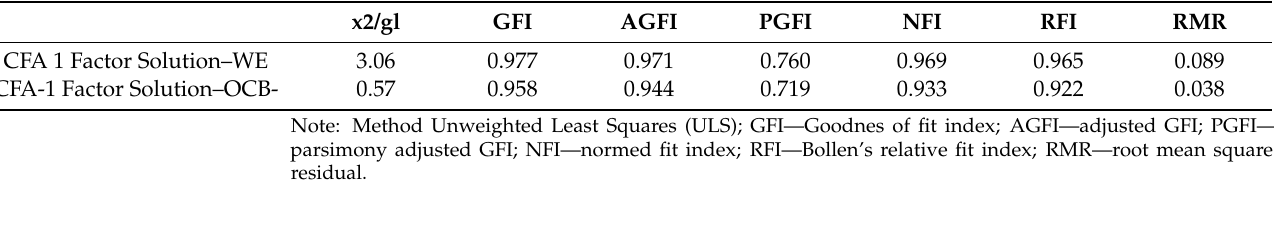
Table A1. Confirmatory Factor Analysis–Fit Indexes for 1 Factor Solution (WE and